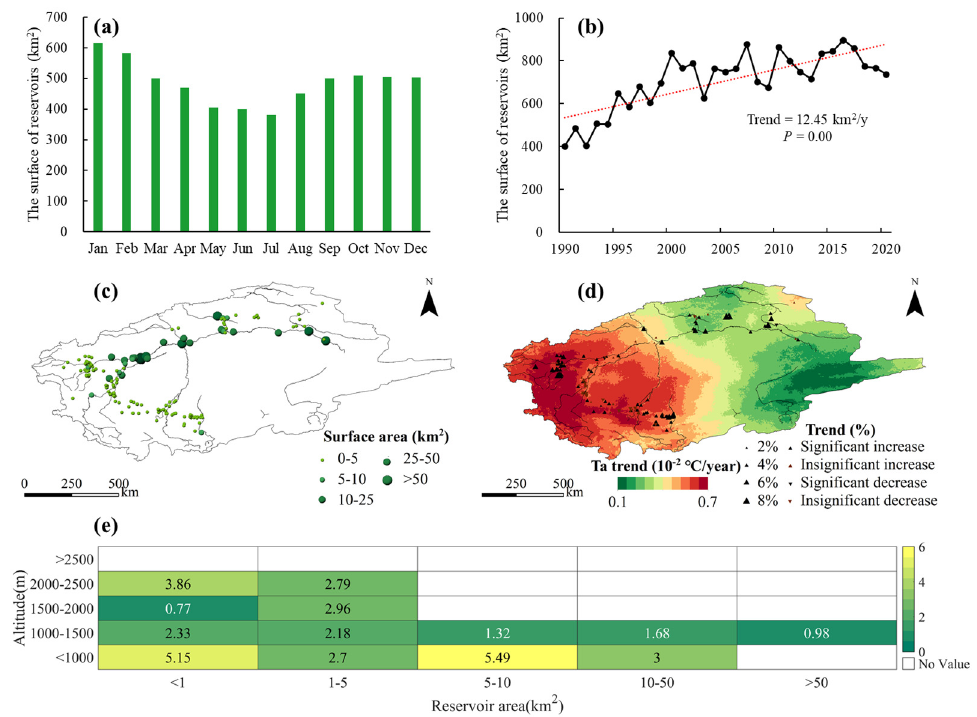
Figure 3. Reservoir area in TB from 1990–2019: ( a ) Annual variation in reservoir area; ( b ) interannual variation in reservoir area; ( c ) average reservoir area; ( d ) variation trend in reservoir area; and ( e ) variation trend in reservoir area at different elevations.